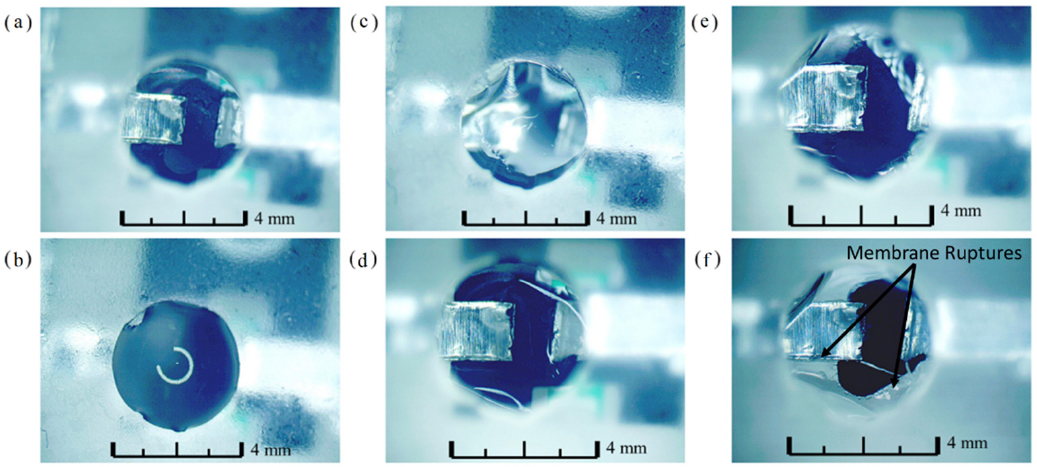
Figure 5. Well activation with simulated ISF (45 × Optical Magnification): ( a ) Top of dry well prior to filling; ( b ) Well above membrane filled with water before activation; ( c ) Well immediately after activation; ( d ) Well thirty seconds post-activation; ( e ) Well two minutes post-activation; ( f ) Well with sensing strip removed.